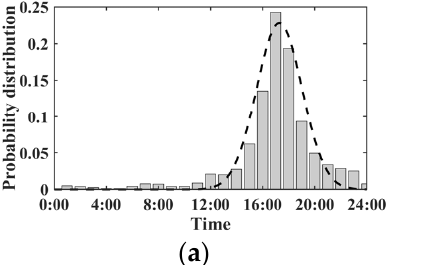
Figure 2. Distribution of end times of trip on weekdays. ( a ) Distribution of end times of works trips, ( b ) Distribution of end times of social shopping trips.